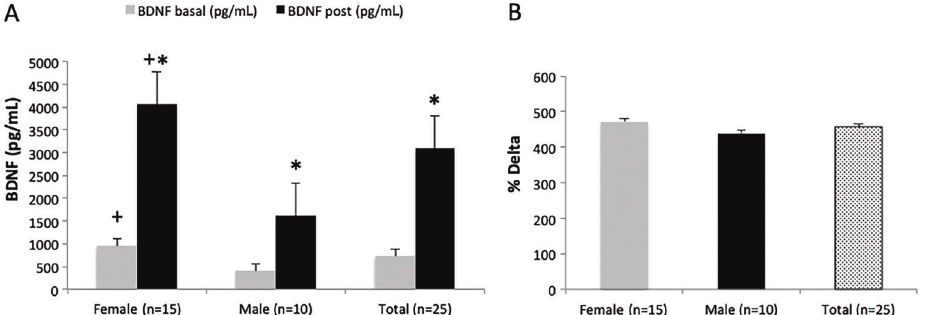
Figure 2. Plasma brain-derived neurotropic factor (BDNF) before (basal) and after the judo training session. A , BDNF was higher in females than in males at rest (P=0.001) and after training session (P=0.007). Increase in BDNF levels was observed in the whole sample (P o 0.0001) as well as in female (P=0.001) and male groups (P=0.0004). B , Delta BDNF was similar between females and males (P=0.801). Data are reported as means ± SE. *Statistically signi fi cant difference between rest and after training session; + statistically signi fi cant difference between males and females (Mann-Whitney and Student ’ s t